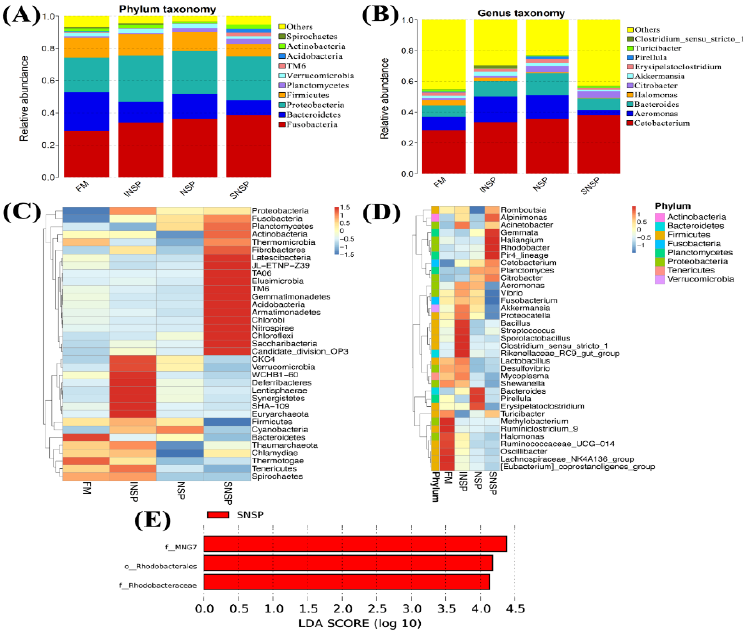
Figure 2. Intestinal flora structure of grass carp fed with experimental diets. ( A ) and ( C ) bacteria phylum level composition in stacked maps and clustered heat maps, respectively; ( B ) and ( D ) bacteria genera level composition in stacked maps and clustered heat maps, respectively; ( E ) LEfSe analysis results.